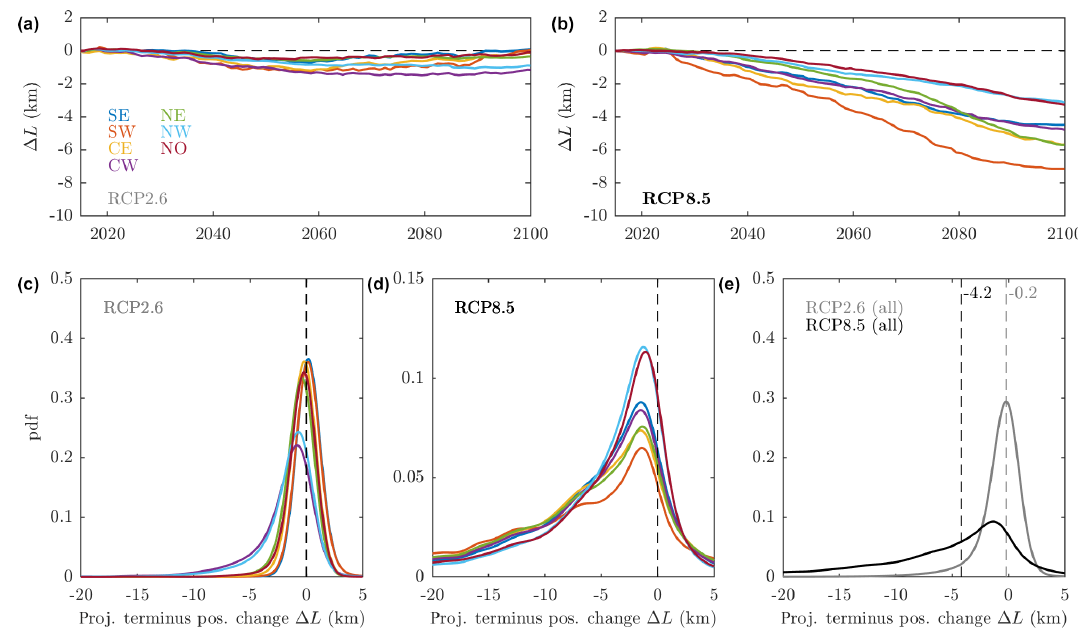
Figure 10. Projected tidewater glacier terminus position change by sector as forced by the climate model MIROC5. (a, b) Time series of median retreat by sector under (a) an RCP2.6 scenario and (b) an RCP8.5 scenario. (c–e) Probability distributions for tidewater glacier terminus position change by 2100. Panel (c) shows the RCP2.6 scenario by sector, panel (d) shows the RCP8.5 scenario by sector, while panel (e) shows full ice sheet distributions for both RCP2.6 and RCP8.5. Colors in (b) – (d) are the same as for the legend in (a) . The vertical dashed lines and number labels in (e) indicate the median retreat in kilometers for each emissions